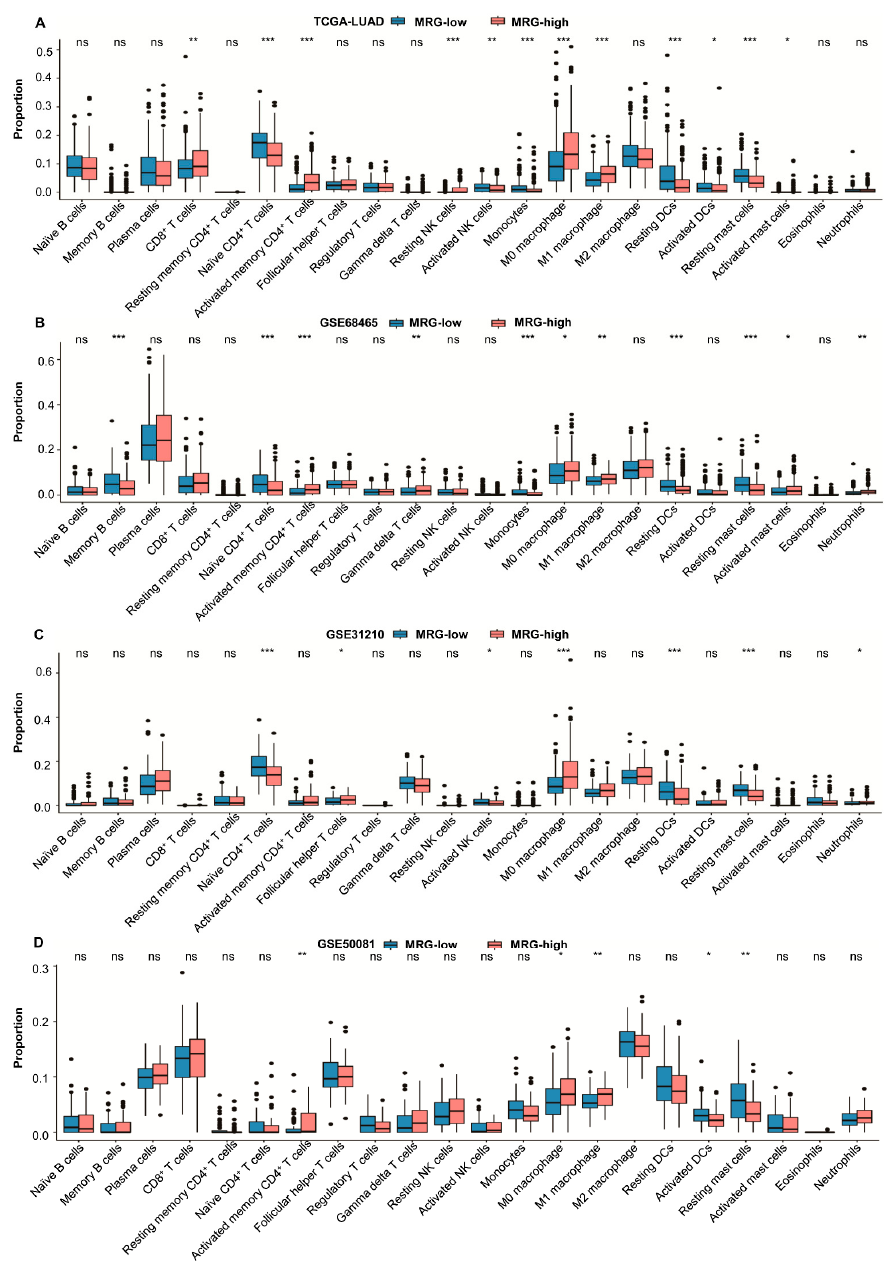
Figure 5. The infiltrated immune cells in different MRG subgroups. ( A ) The proportions of infiltrated cells in different MRG subgroups from TCGA cohort ( n = 500). ( B ) The proportions of infiltrated cells in different MRG subgroups from GSE68465 cohort ( n = 442). ( C ) The proportions of infiltrated cells in different MRG subgroups from GSE31210 cohort ( n = 226). ( D ) The proportions of infiltrated cells in different MRG subgroups from GSE50081 cohort ( n = 127). The scattered dots represent the immune score. The thick lines represent the median value. The bottom and top of the boxes are the 25th and 75th percentiles (interquartile range), respectively. Significant statistical differences between the two subgroups were assessed using the Wilcoxon test (ns, not significant; * p < 0.05; ** p < 0.01; *** p <